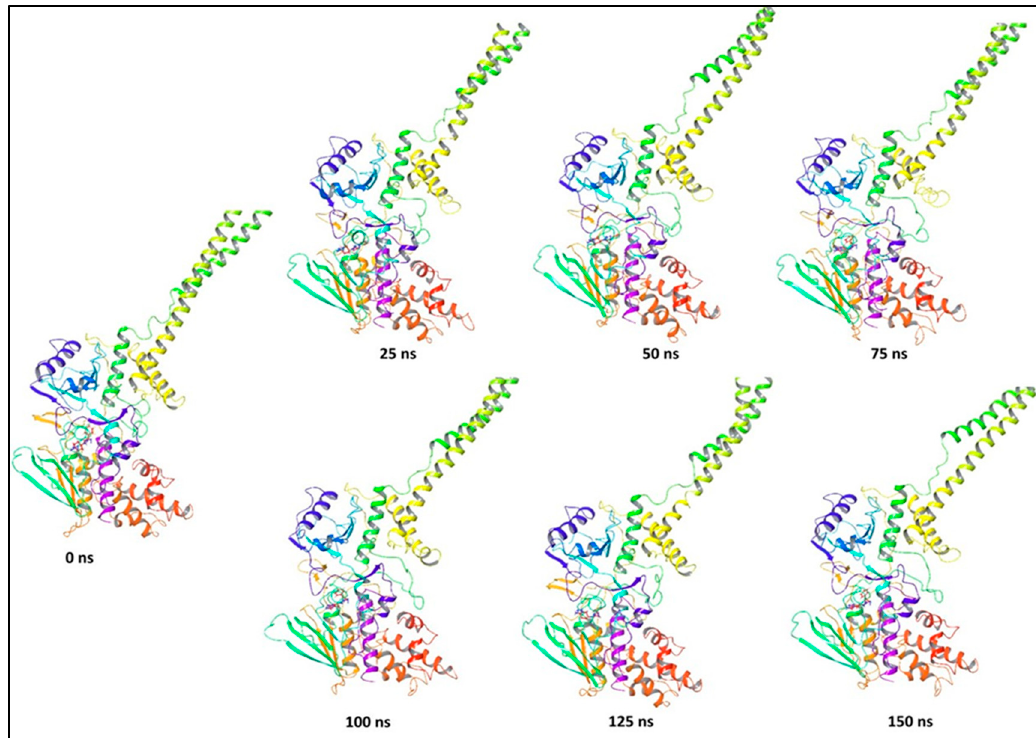
Figure 22. Stepwise trajectory analysis for every 25 ns displaying the protein and ligand conformation during 150 ns of simulation of LSD-compound 1 .